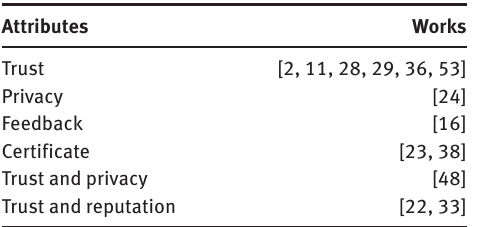
Table 1: Analysis Based on Attributes.